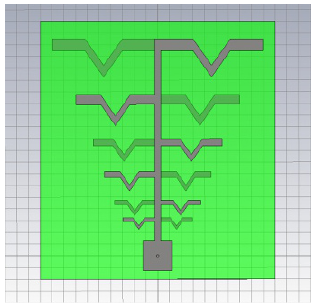
Figure 6. LPKFA with flare angle 70°.